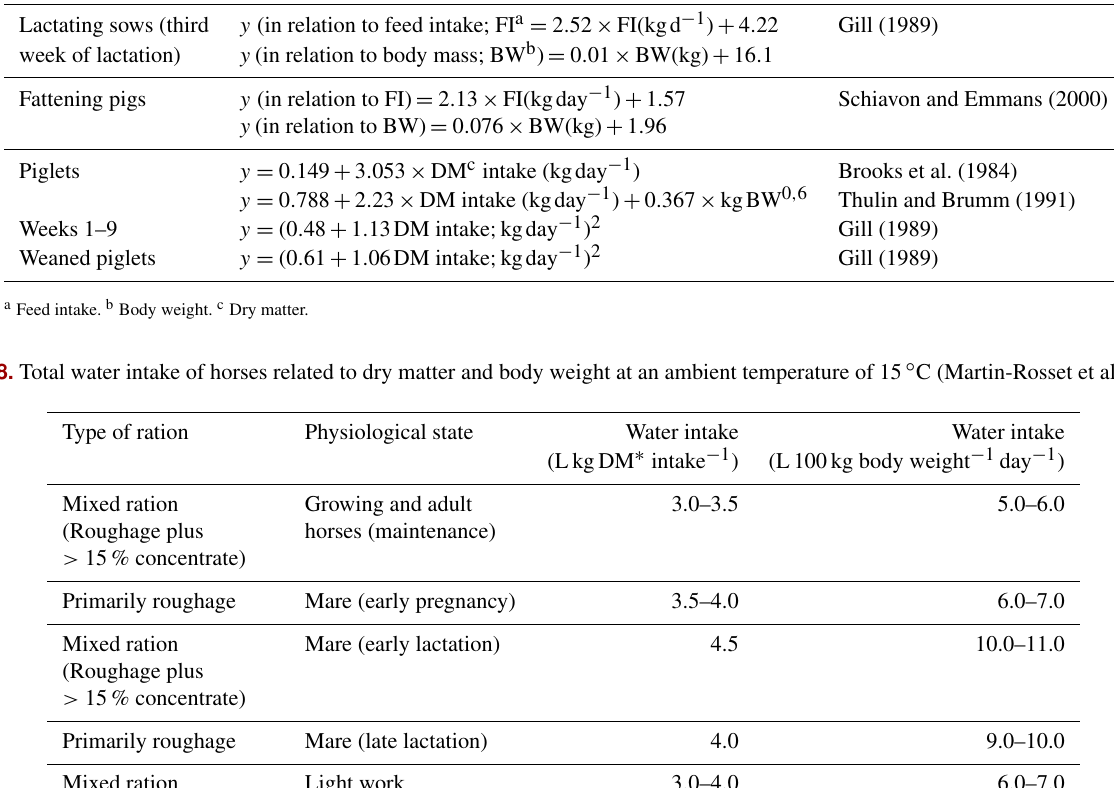
Table 7. Equations to predict the water intake of pigs depending on various influencing factors by some authors. Category